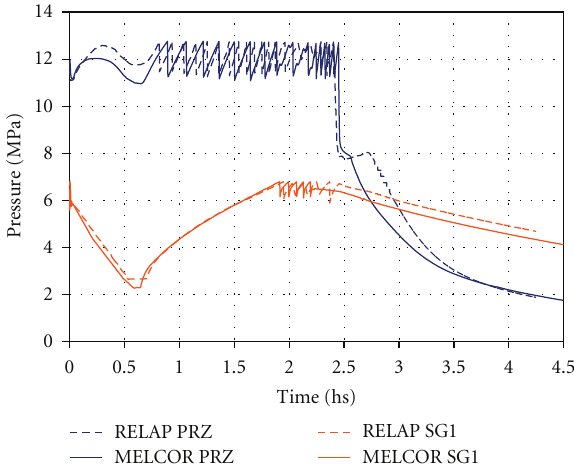
Figure 11: Pressures in primary and secondary systems. Figure 12: Steam generator 10 and 20 water levels.